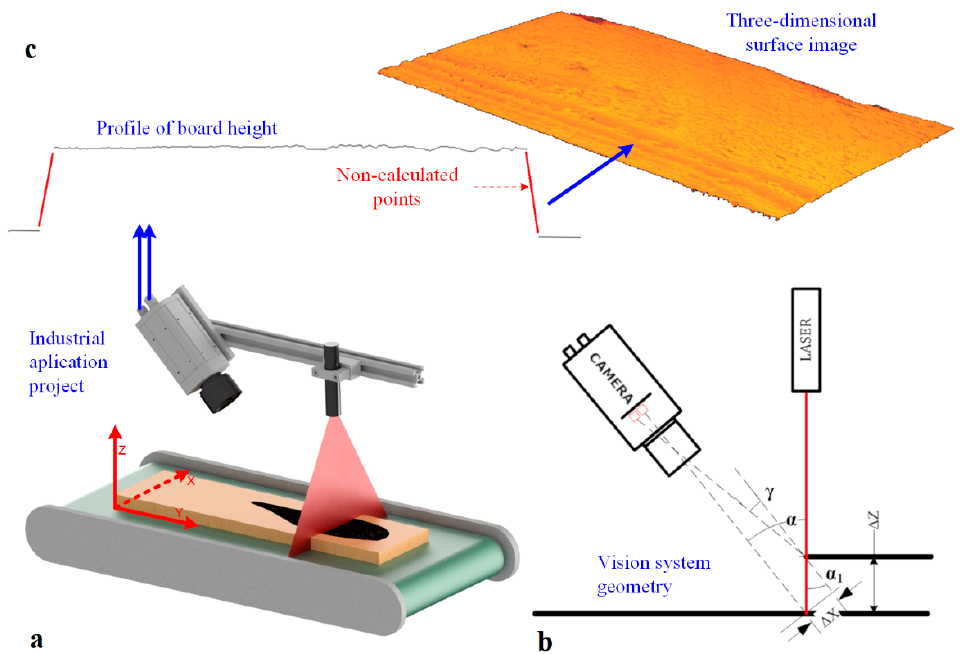
Figure 2. 3D surface image acquisition: ( a ) vision station model, ( b ) vision system geometry configuration, ( c ) height profile and the 3D surface of the board. ration, ( c ) height profile and the 3D surface of the